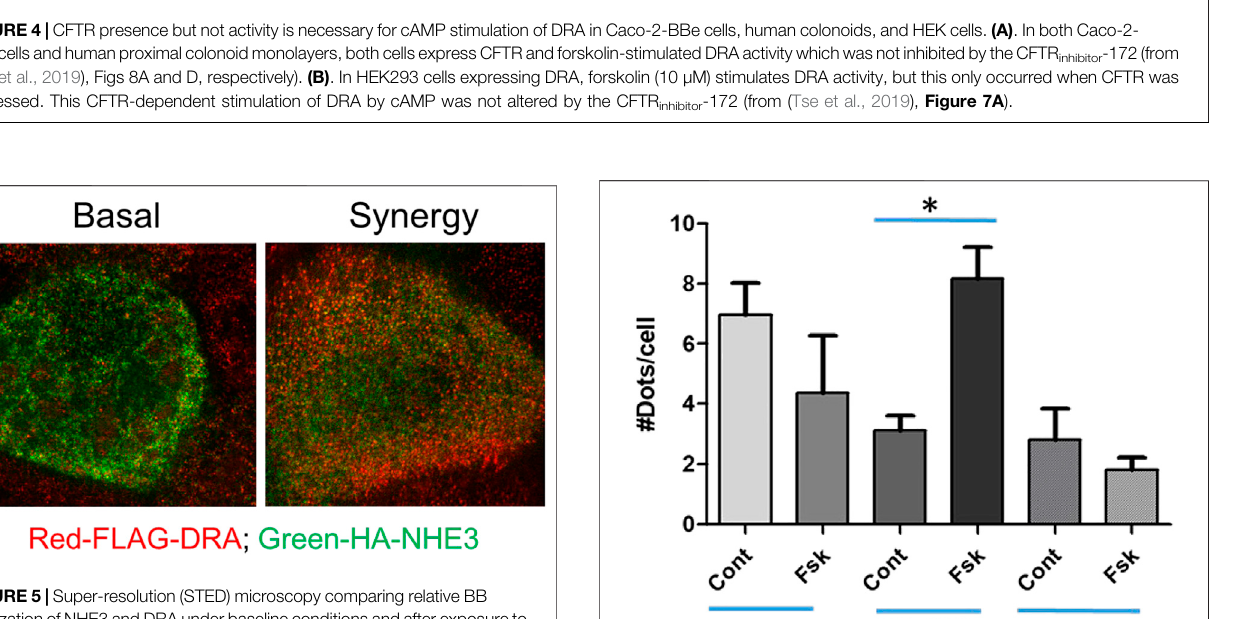
FIGURE 5 | Super-resolution (STED) microscopy comparing relative BB localizationofNHE3andDRAunderbaselineconditionsandafterexposureto low concentrations of forskolin plus ATP which inhibits NHE3 and stimulates DRA activity. Immunostaining: Caco-2/FLAG-DRA stable cells grown in the 12-mm Transwell inserts were infected withadeno-HA-NHE3 and studied 48 h later. The cells were serum-starved for ~4 h and treated on basolateral and apical surfaces with 1 µM FSK for 7 min and then with 0.25 µM ATP apically for 3 min. See methods for fi xation, processing, and imaging details. This study shows there is more NHE3 than DRA on the outer BB under baseline conditions, but the opposite scenario is observed after exposure to forskolin plus ATP.